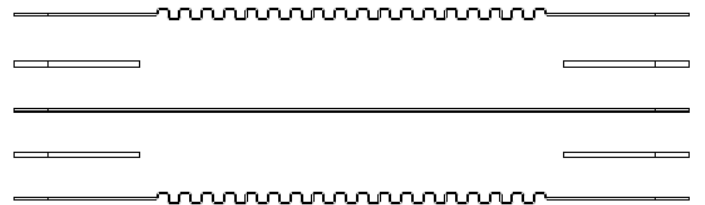
Figure 2. Bipolar plate module illustration in the study.